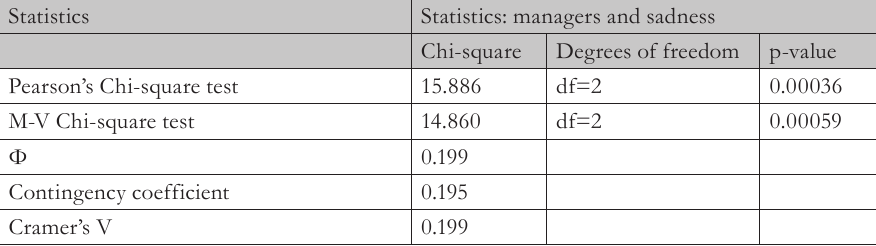
Tab. 4 – Dependence between the job position and sadness. Source: own